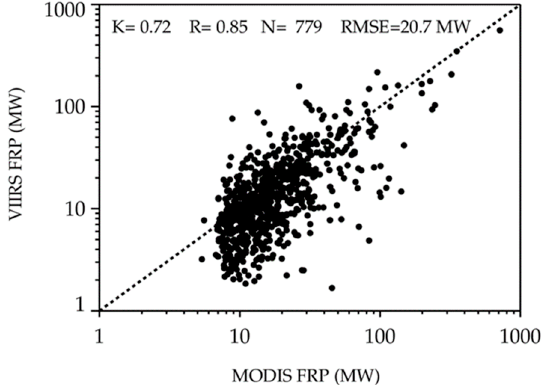
Figure 3. Scatter plot of MODIS fire-pixel fire radiative power (FRP) versus the paired VIIRS FRP